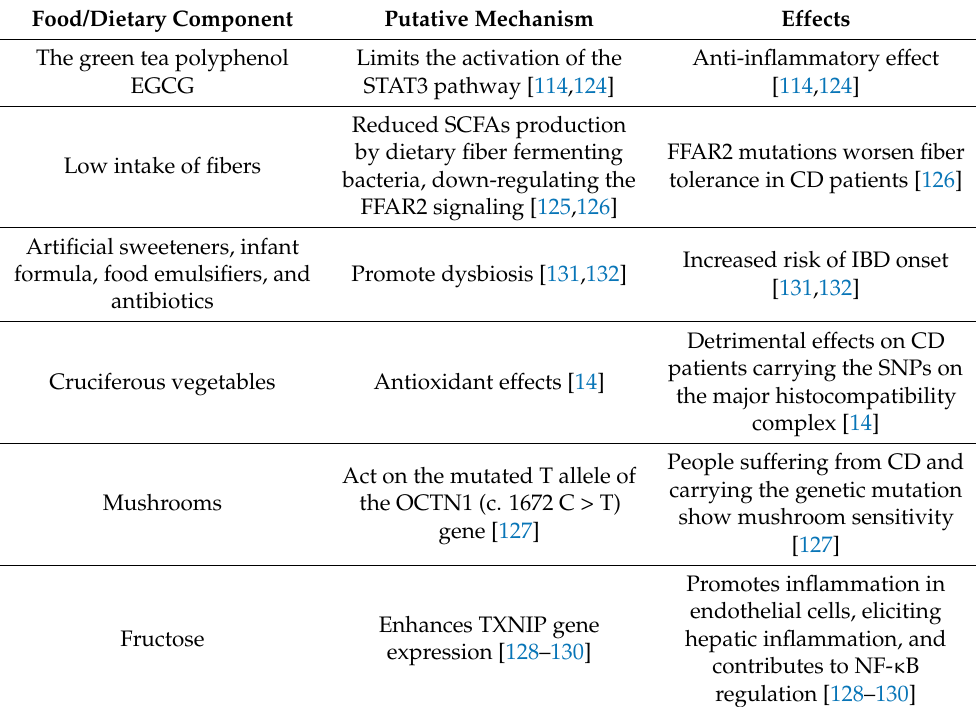
Table 3. Food/dietary components affecting gene expression or other factors with related mecha- nisms and